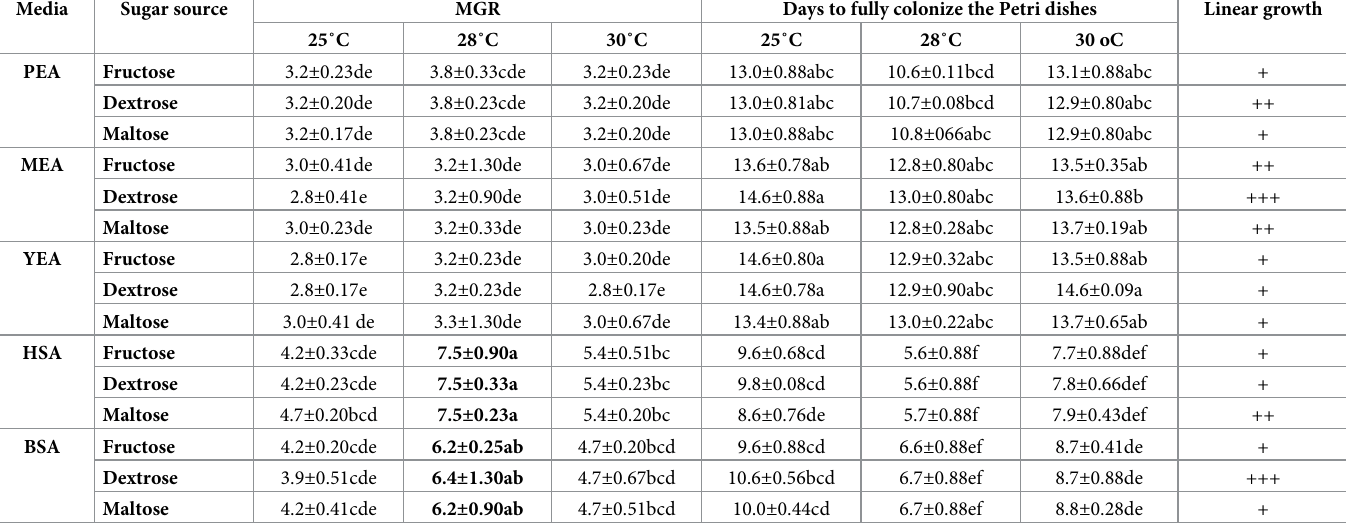
Linear growth; +: The lowest degree, ++: The mediocre degree, +++: The highest degree. Average values (four replicates) ± standard error are given. Means followed by the same letter are not significantly different according to LSD at 0.01 probability